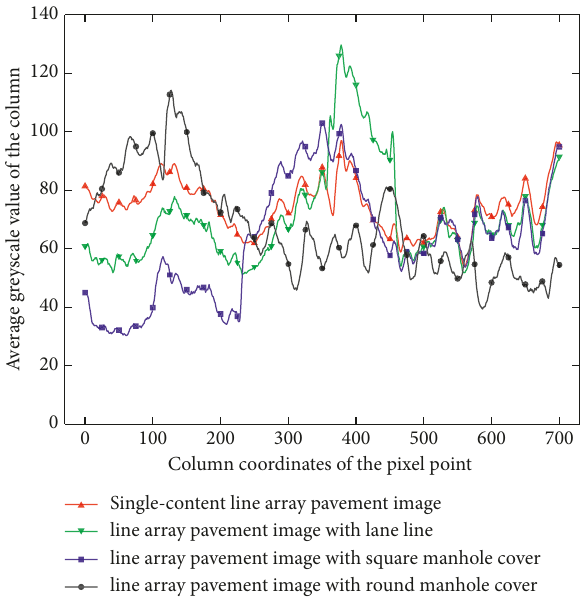
Figure 2: Grayscale distribution of the different line array pave- ment